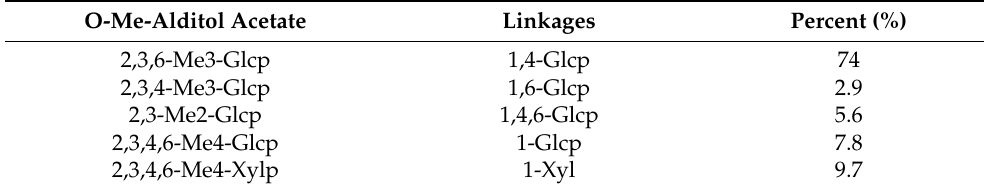
Figure 1. Purification and structural characterization of OPA. ( A ) Purification of OPA using gel filtration chromatography and an elution curve of a molecular mass standard; ( B ) HPGPC chromatography of OPA; ( C ) FT-IR spectrum of OPA; ( D ) the monosaccharide composition of OPA by HPLC; the left was the peak of monosaccharide standerds, the right was the peak of OPA. Table 3. Methylation analysis of